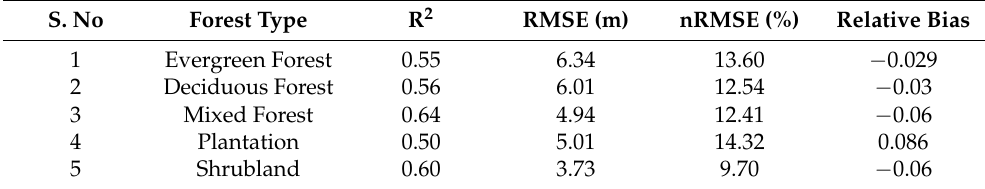
Table 5. Error analysis and model validation for the different forest types ( p -values < 0.001). S. No Forest Type R